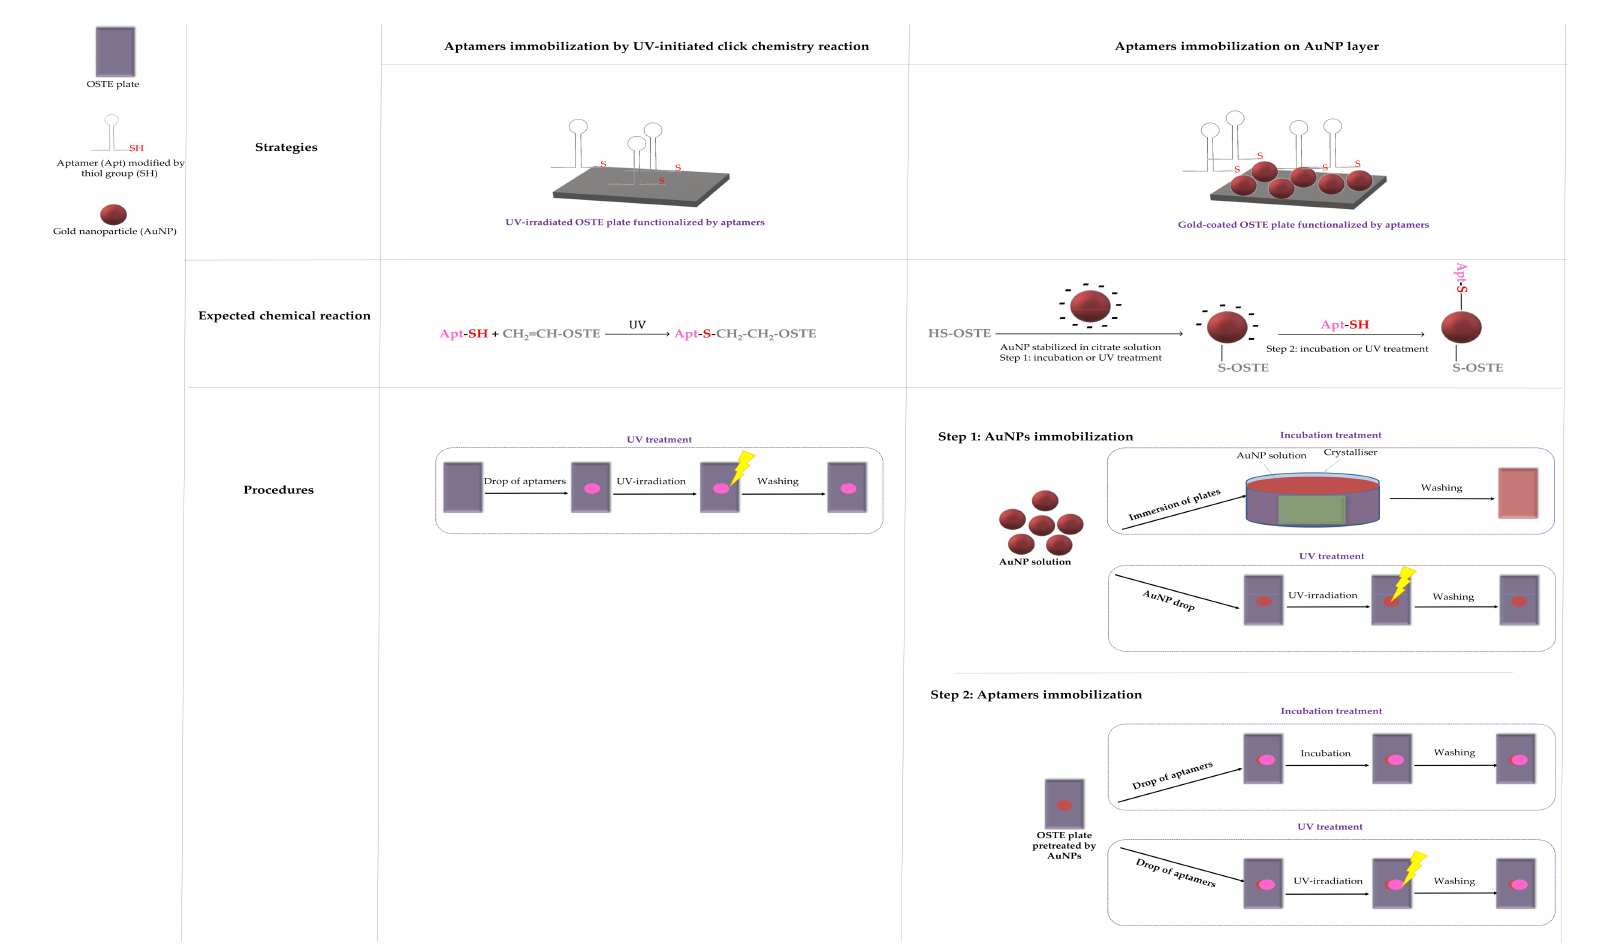
Figure 1. Strategies and procedures of